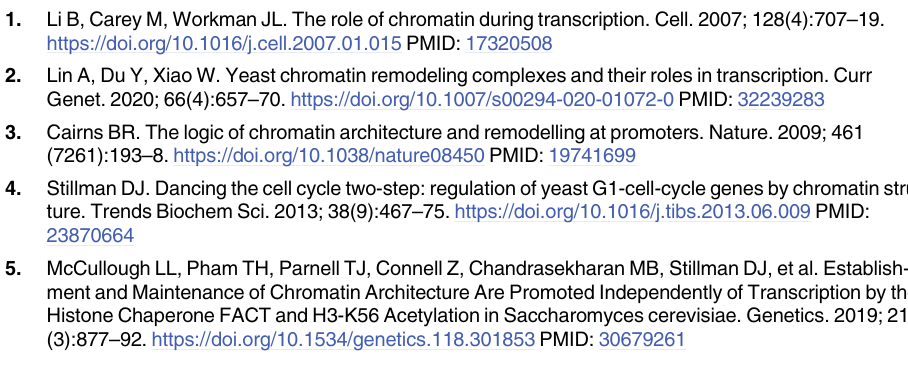
S5 Table. Information on ORFs located downstream of ATR. S6 Table. Values for data used to create graphs in the figures. The Excel file contains multi- ple tabs, with each tab containing the data for a single